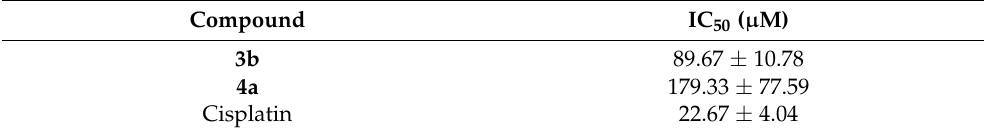
Table 4. IC 50 values of compounds 3b , 4a, and cisplatin for A549